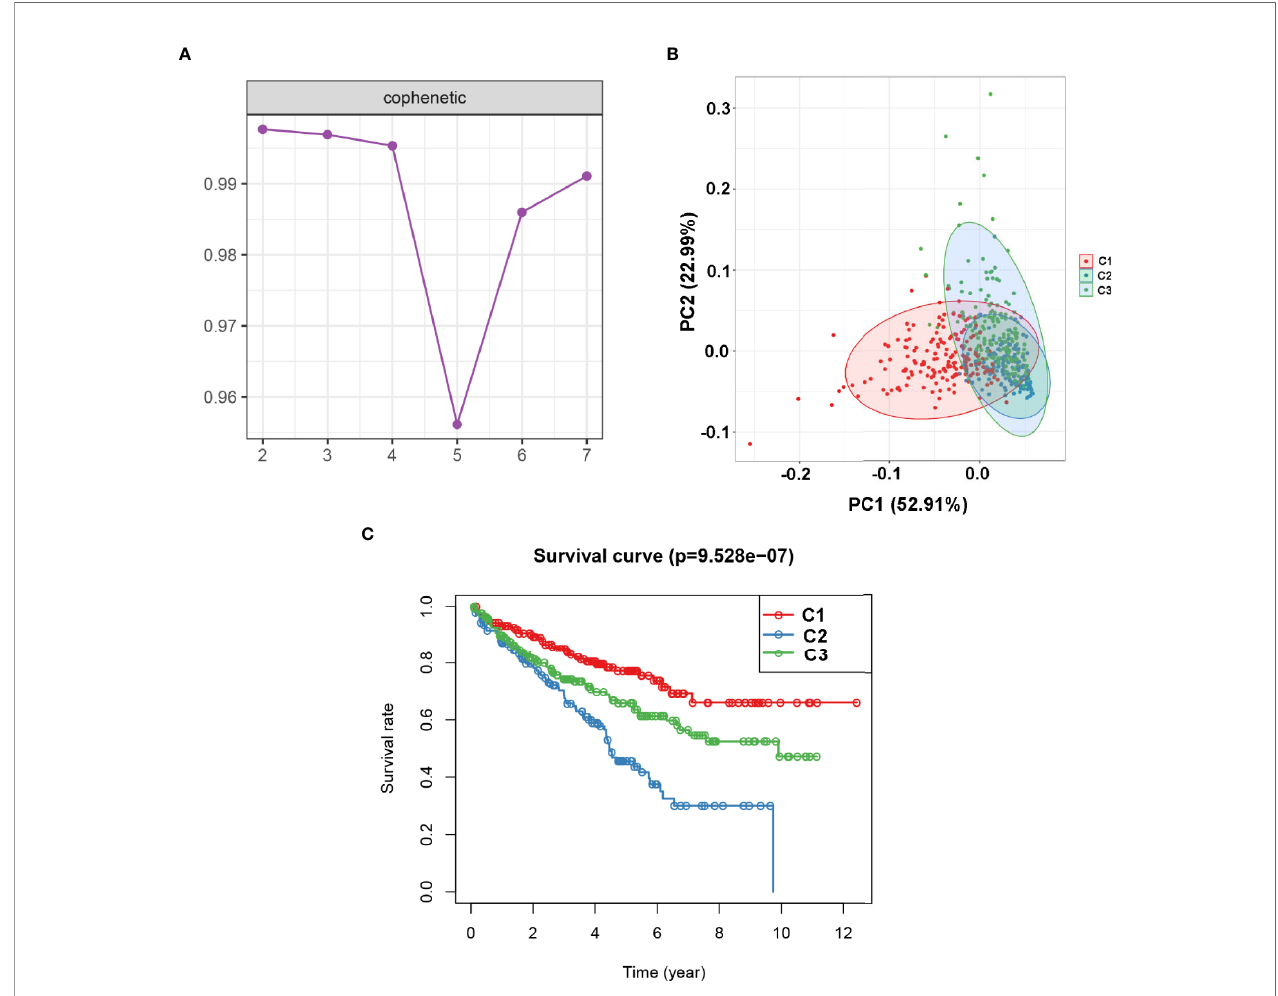
FIGURE 9 | Identi fi cation of molecular subtype of ccRCC based on the EMT-related lncRNA expression in the TCGA dataset. (A) NMF clustering using 491 NMF- related lncRNAs. The cophenetic correlation coef fi cients were shown when k = 2 to k = 7. (B) Principal components analysis (PCA) for the EMT-related lncRNA expression. (C) Kaplan-Meier curve analysis for the two